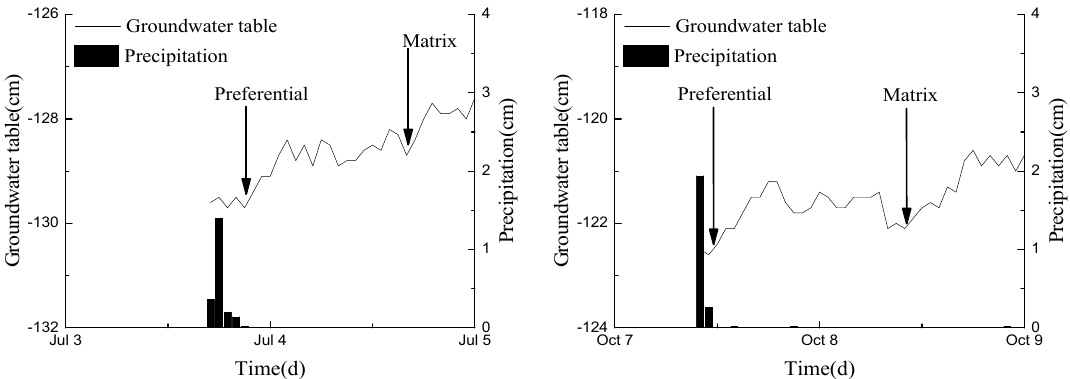
Figure 12. Response of groundwater tables to precipitation events during 3 July and 7 October. Water table series show two different water rising periods after rainfalls, suggest both preferential flow and matrix flow exist.